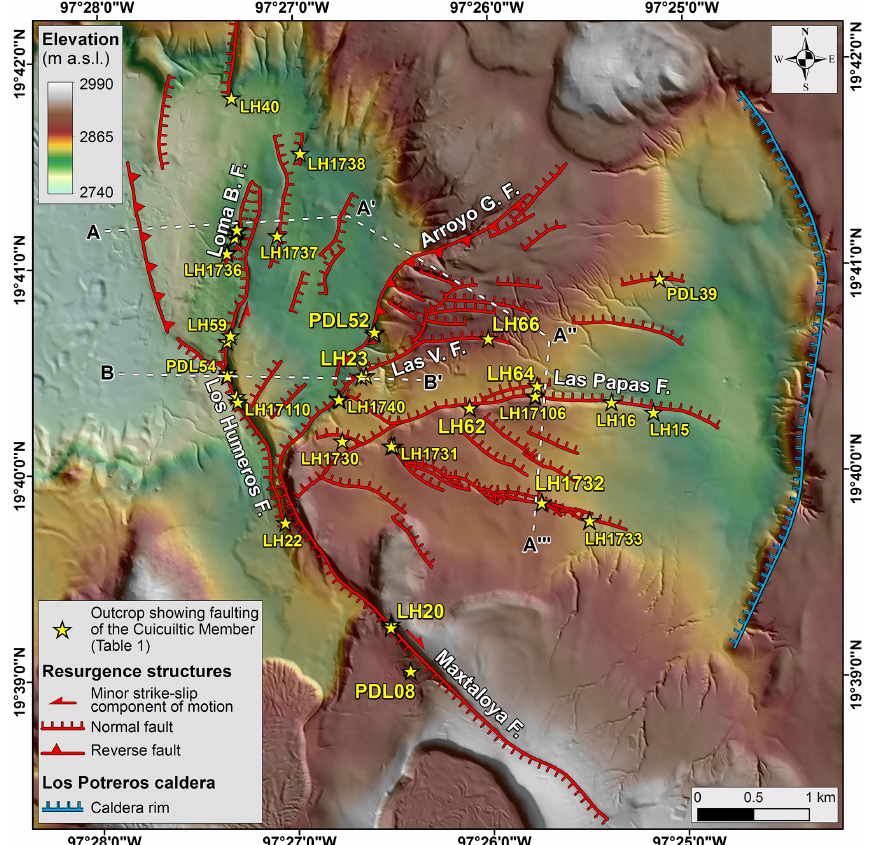
Figure 1. Volcanotectonic map of the Los Potreros caldera area, on a DEM (illuminated from the east) (modified from GEMex, 2019, and Norini et al., 2019). Las V. F.: Las Viboras fault; Arroyo G. F.: Arroyo Grande fault; Loma B. F.: Loma Blanca fault. Location of outcrops